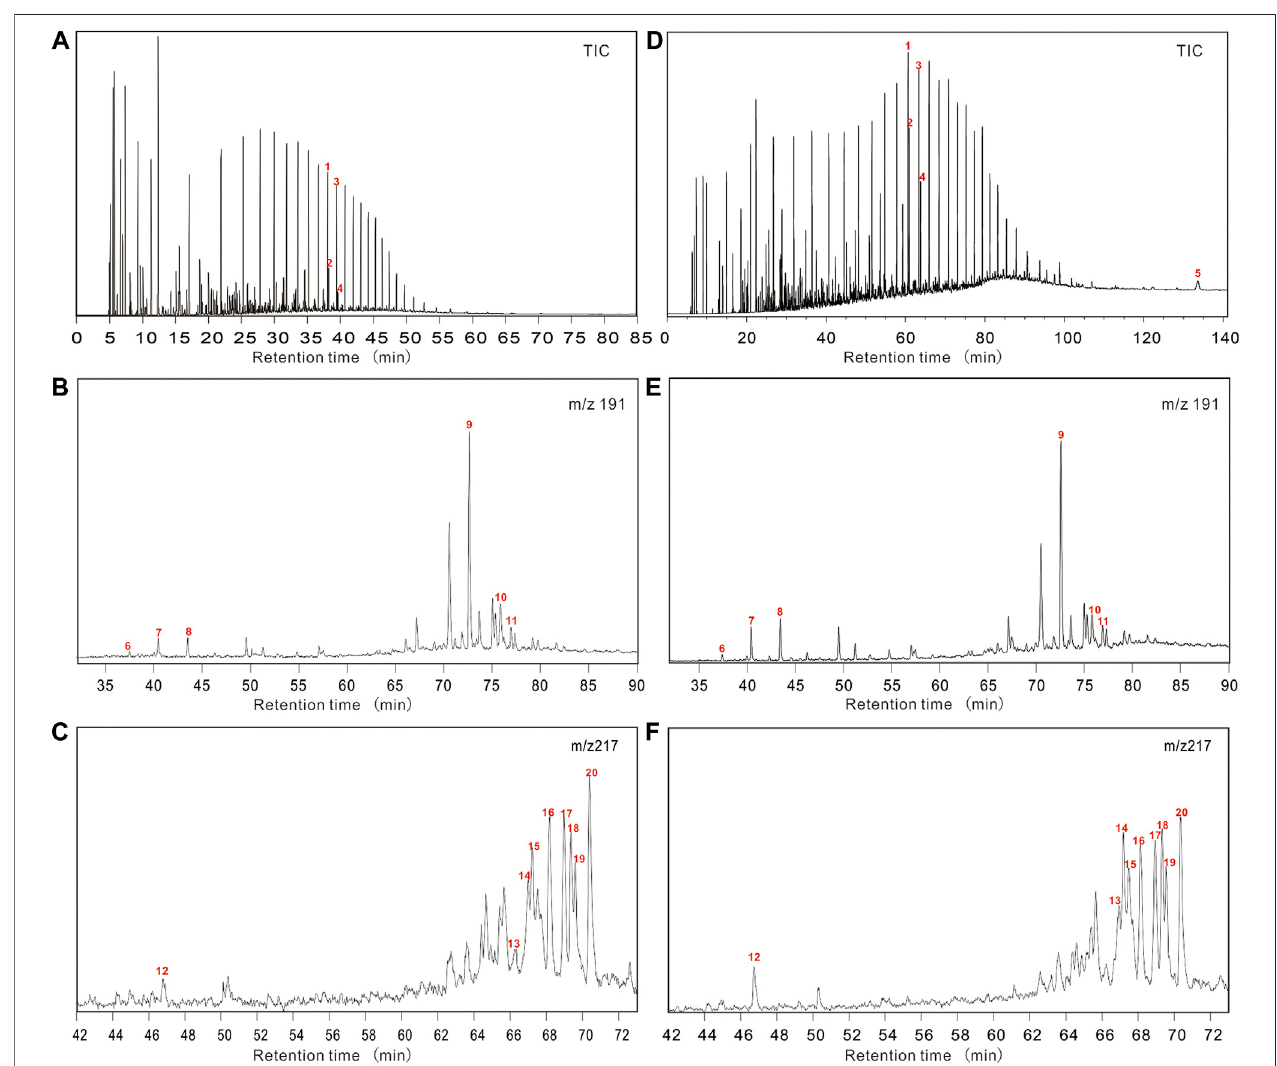
FIGURE11| ThebiomarkerspectrogramsofoilswithdifferentoriginsintheJimsarSag. (A,D) :TICchromatograms ofoilsfrom wellsJ15(Carboniferousreservoir) and J251 – H(P 2 lreservoir); (B,E) :m/z191chromatograms ofoilsfrom wells J15 (Carboniferous reservoir) and J251 – H(P 2 lreservoir); (C,F) :m/z 217chromatograms of oils from wells J15 (Carboniferous reservoir) and J251 – H (P 2 l reservoir). Note: (1) n-C 17 ; (2) Pr; (3) n-C 18 ; (4) Ph; (5) β -carotene; (6) C 19 tricyclic terpane; (7) C 20 tricyclic terpane; (8)